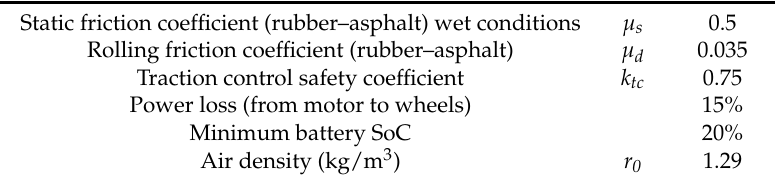
Table 3. Application example: system